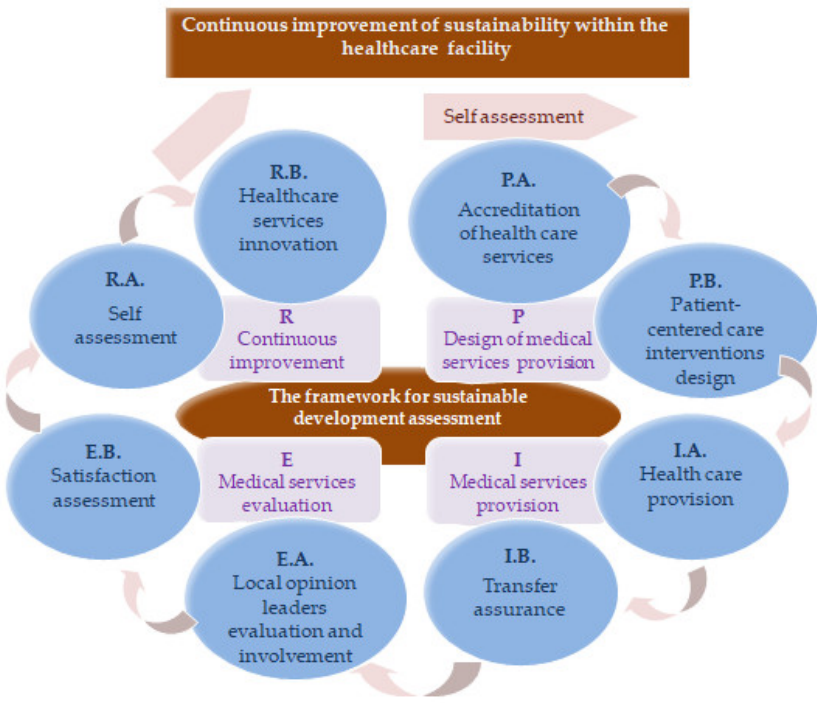
Figure 3. The basic activities of the continuous improvement cycle for the sustainable development of the healthcare facility.